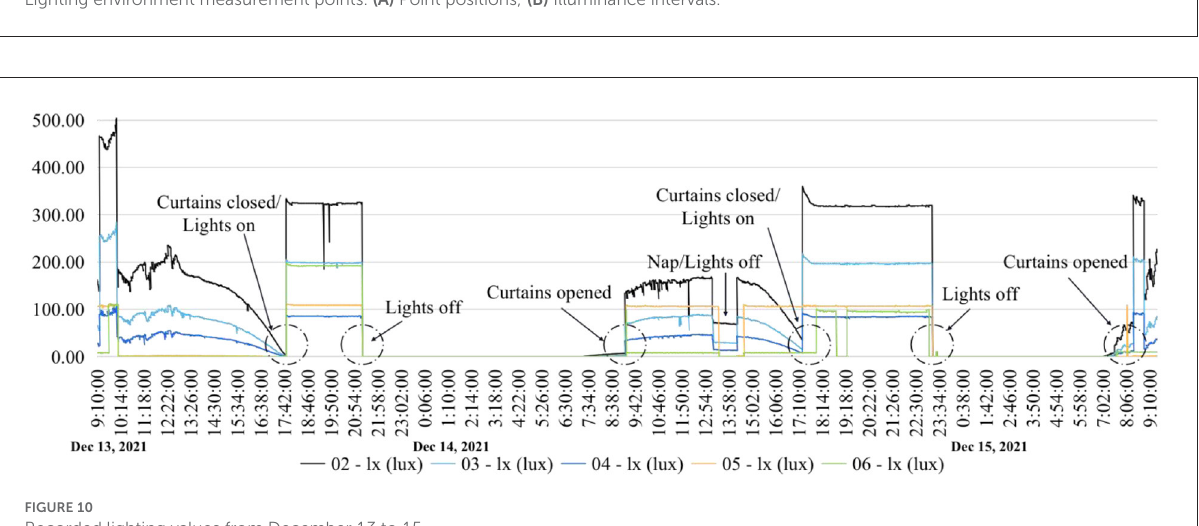
FIGURE9 Lighting environment measurement points. (A) Point positions; (B) Illuminance intervals.